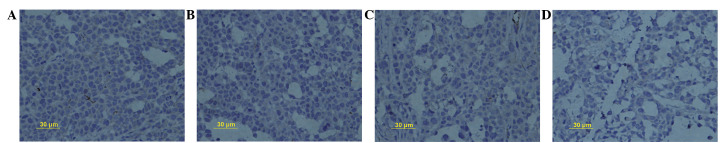
SN50 decreases vascular endothelial growth factor (VEGF) protein expression. Pathological changes in the SGC7901 tumor cells in (A) the model control and (B–D) experimental groups, (B) 5, (C) 10 and (D) 15 days after treatment with SN50. Hematoxylin and eosin (HE) staining; magnification, x200.